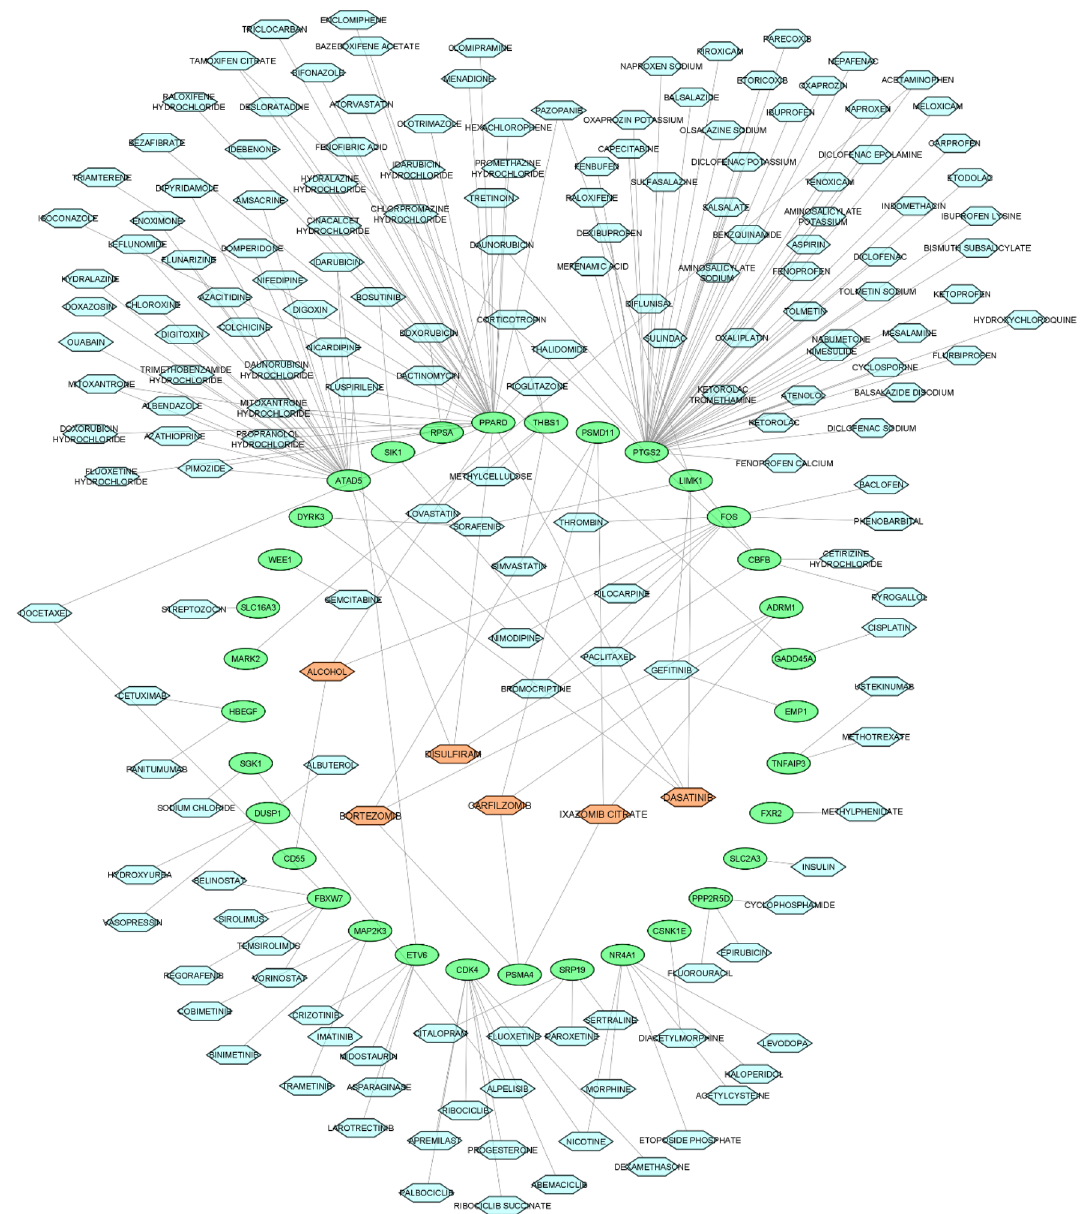
Figure 6. The candidate drug-gene network extracted from DGIdb database. The candidate drugs (lightblue hexagon) identified as regulators of the NBMSC-RNIT subnetwork. Among these drugs, some drugs can regulate more than two gene (red hexagon). Cytoscape v.3.8.2 was used to visualize the